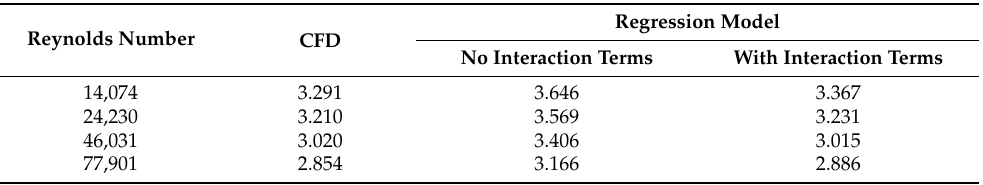
Table 8. Comparison of TPLC prediction between the numerical method and the regression model with design variables at the design point and Reynolds numbers.